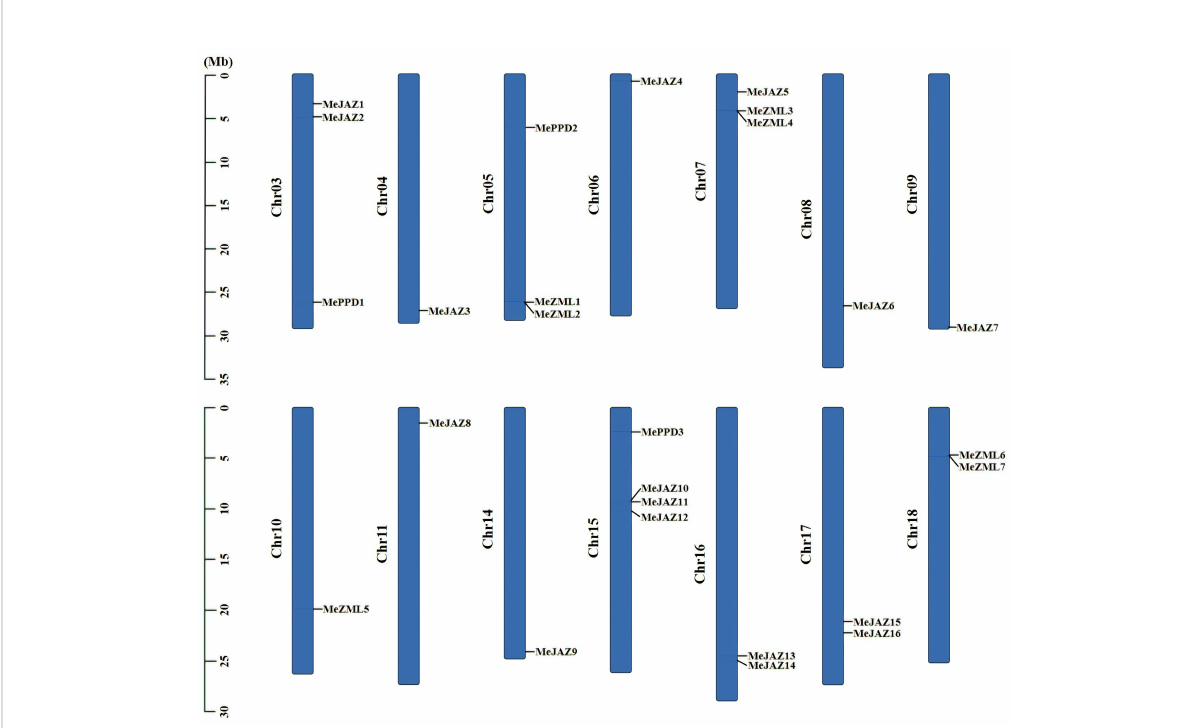
FIGURE 3 Distribution of ZML , PPD and JAZ genes on cassava chromosomes. The chromosome numbers were shown at the left of each chromosome. The genes were listed on the left of the chromosomes. The scale on the left is in million bases